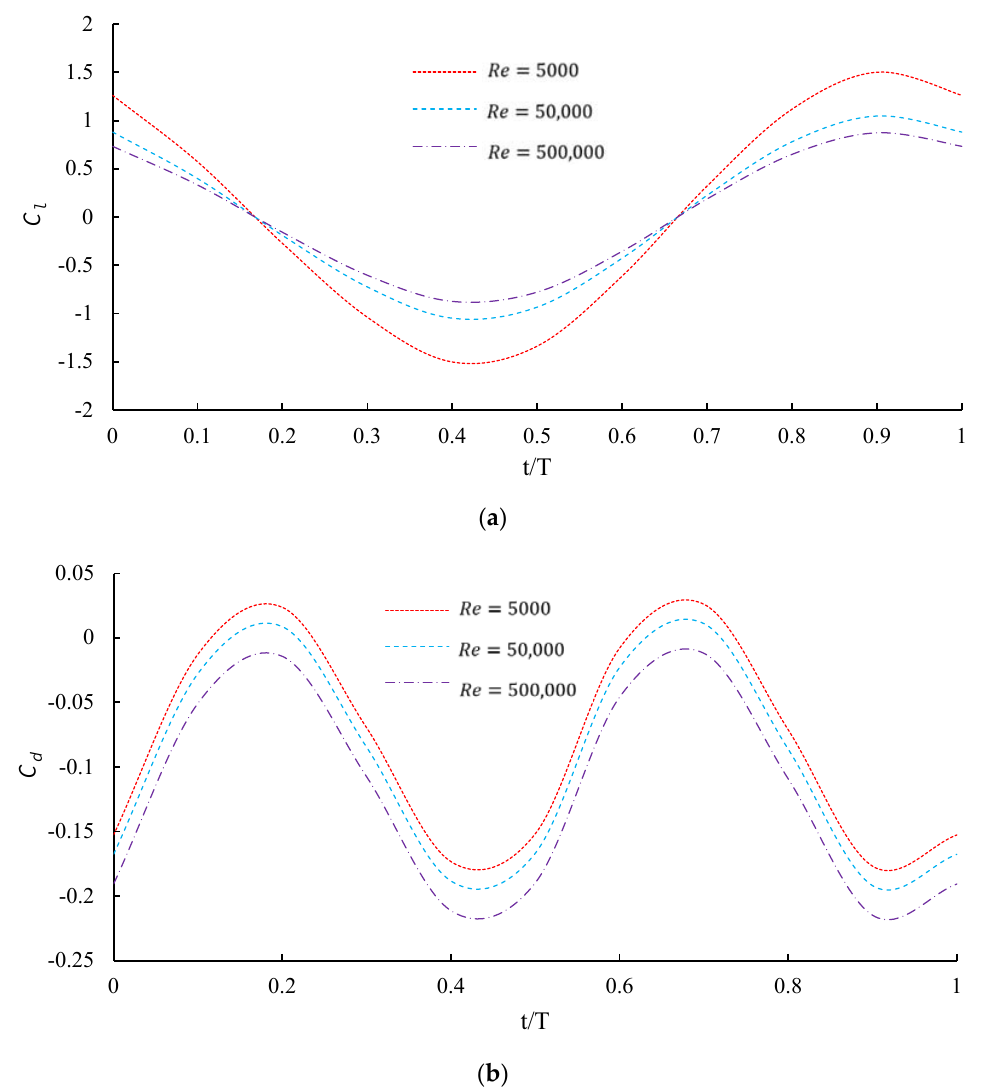
Figure 8. Lift and drag coefficients at different Reynolds numbers. ( a ) The lift coefficient C l ; ( b ) the drag coefficient C d .